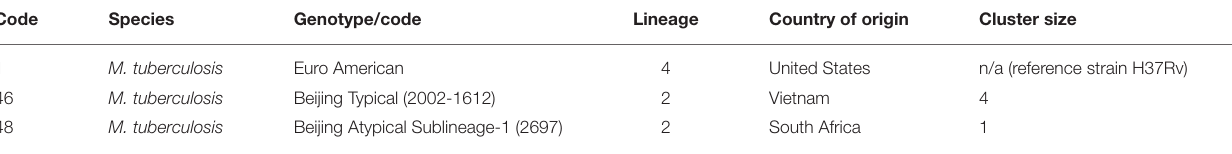
TABLE 1 | Bacterial strains selected for